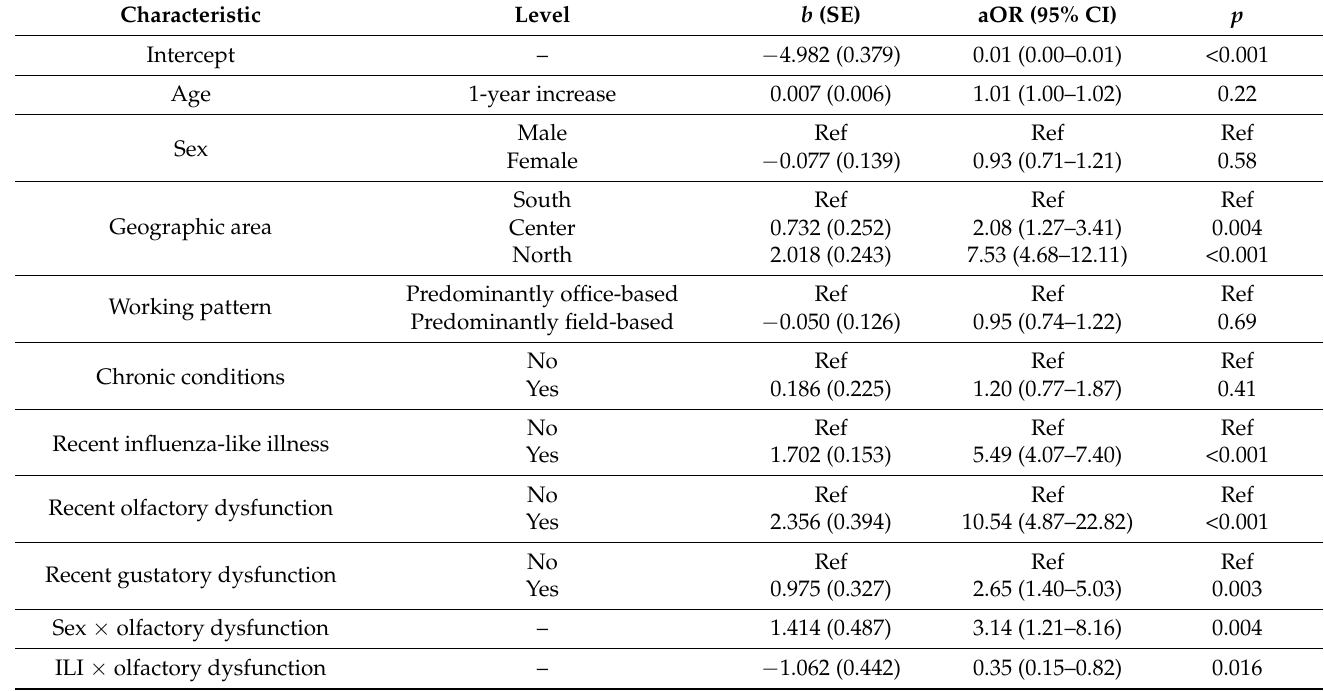
Table 4. Sensitivity analysis including only subjects with the detectable IgG response ( n =